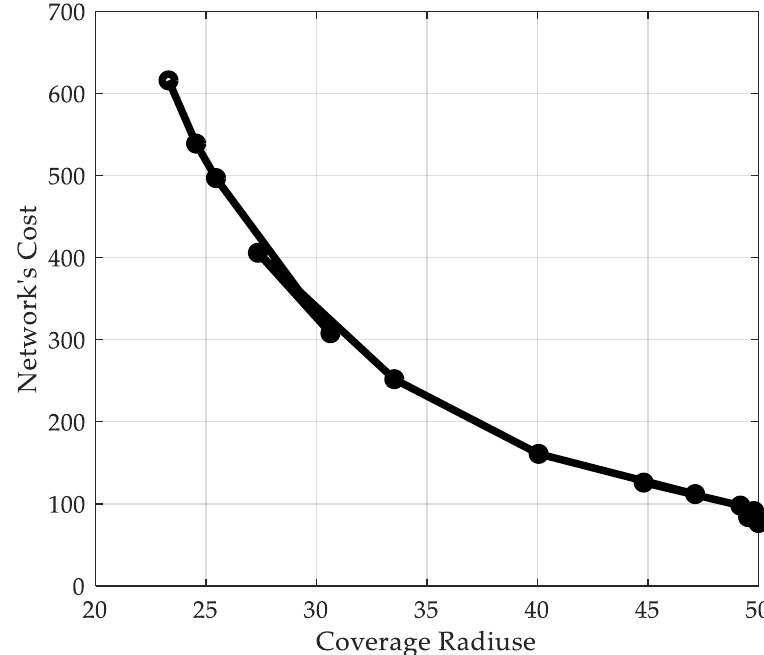
Figure 11. Value of uncovered area and minimization network cost value.